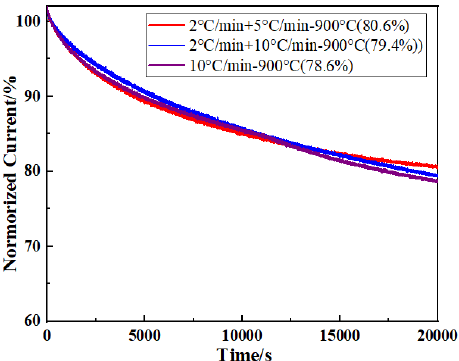
Figure 11. The stability of the Co–ZIF–8 catalyst at 0.7 V in O 2 –saturated 0.1 M KOH.